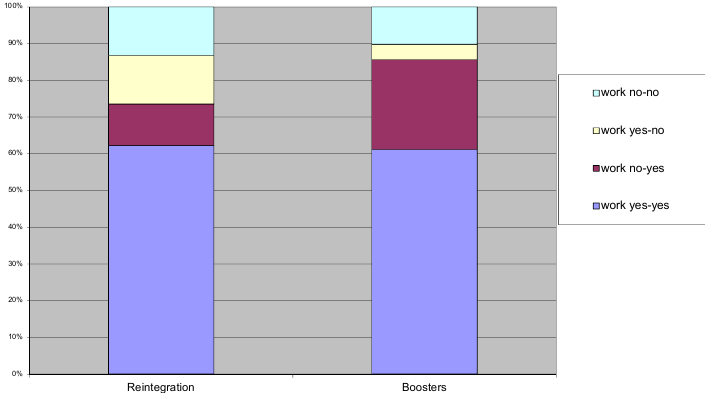
Figure 3: Work comparison – Reintegration v